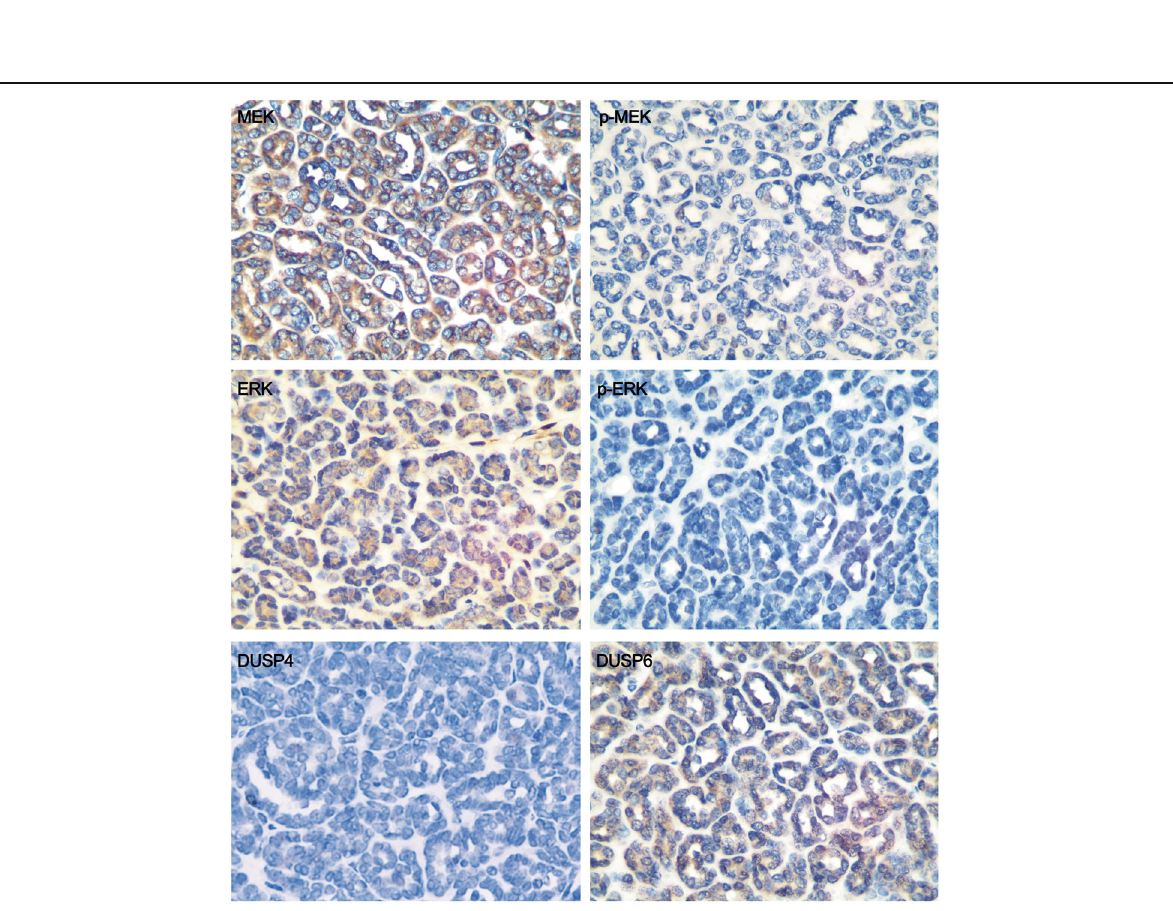
Fig. 5 Immunohistochemical staining for MEK, p-MEK, ERK, p-ERK, DUSP4, DUSP6 in representative MA tissues, 400×. The staining of positive tumor cells ranged from 1+ to 3+, indicating diffuse, moderate, and strong cytoplasmic